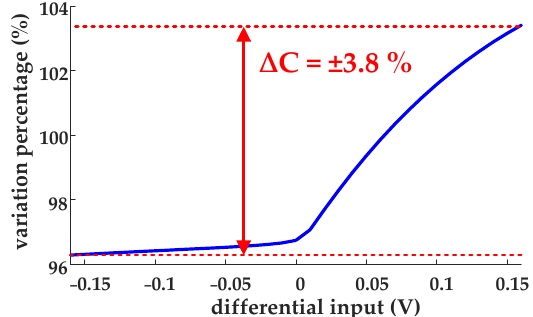
Figure 15. The simulated voltage variation of the total parasitic capacitance.